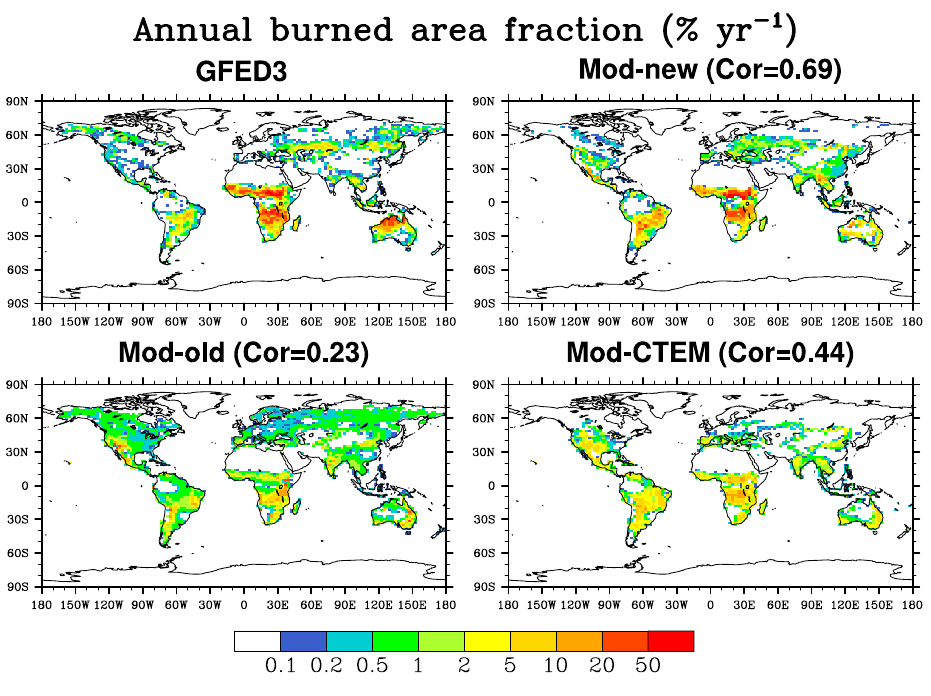
Fig. 9. Spatial distribution of annual burned area fraction averaged over 1997–2004 for GFED3 and CESM1 simulations with different fire parameterizations. The global spatial correlation (Cor) between GFED3 and simulation is also given.